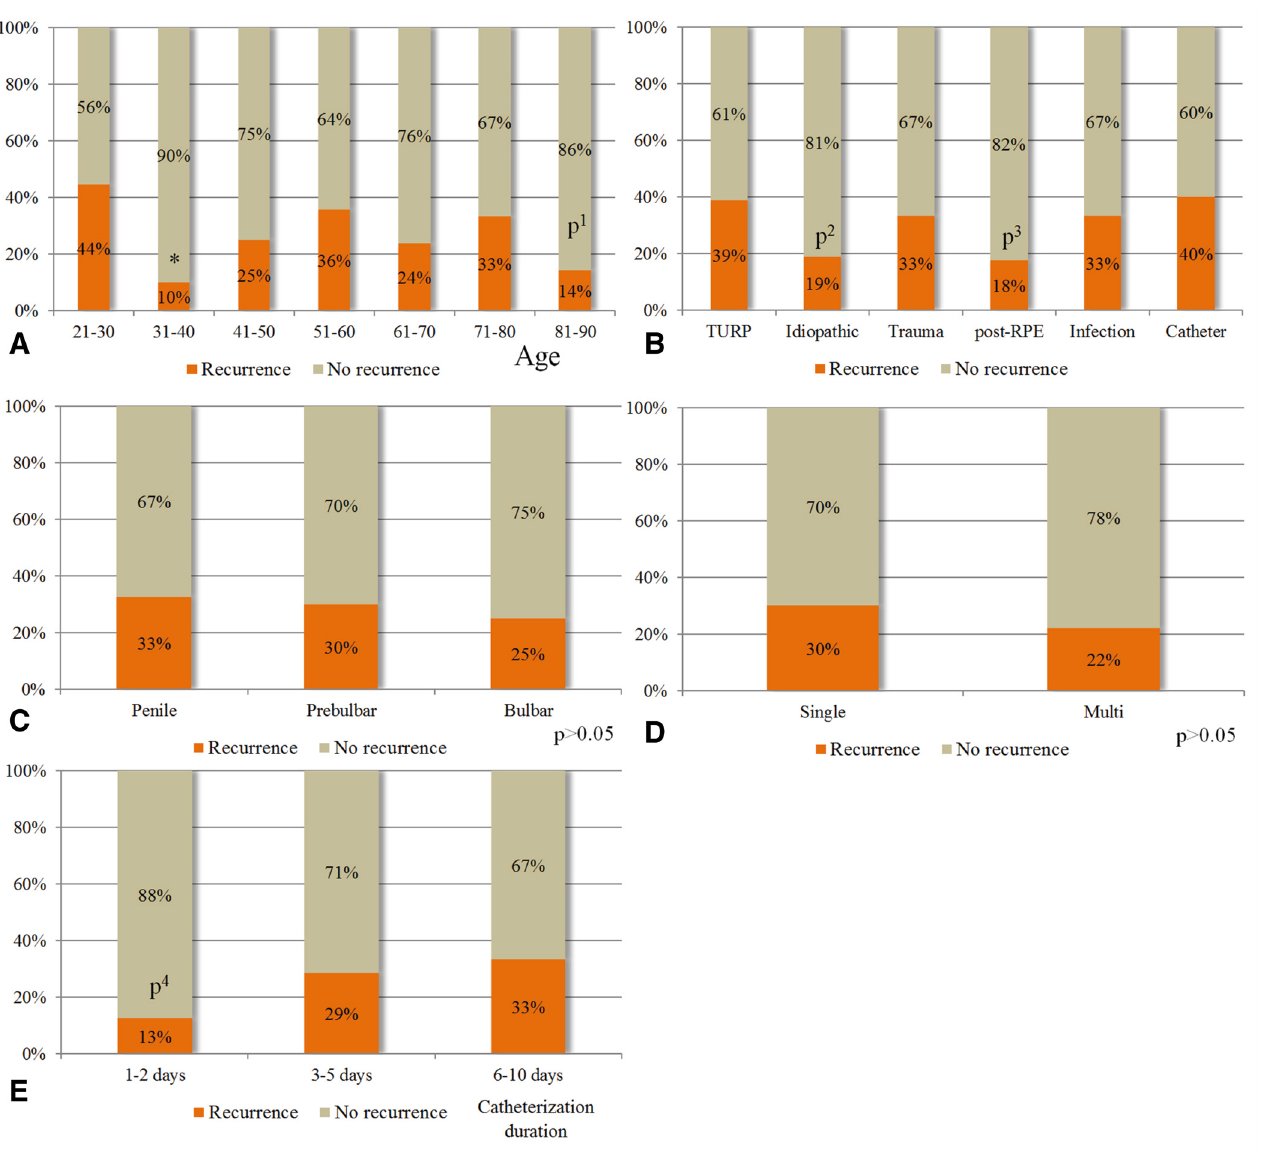
Figure 4. Recurrence rate after the 1 st optical internal urethrotomy in patients with urethral stricture with a length ≤ 1 cm. A - Recurrence rate with respect to the patient age (*n=5; p 1 <0.01). B - Recurrence rate with respect to the stricture etiology (p 2 , p 3 < 0.01 compared to the TURP, trauma, infection and catheterization groups). C - Recurrence rate with respect to the stricture localization. D - Recurrence rate with respect to the number of consecutive strictures in each of the patients. E - Recurrence rate with respect to the catheterization duration (p 4 <0.05 compared to the other two